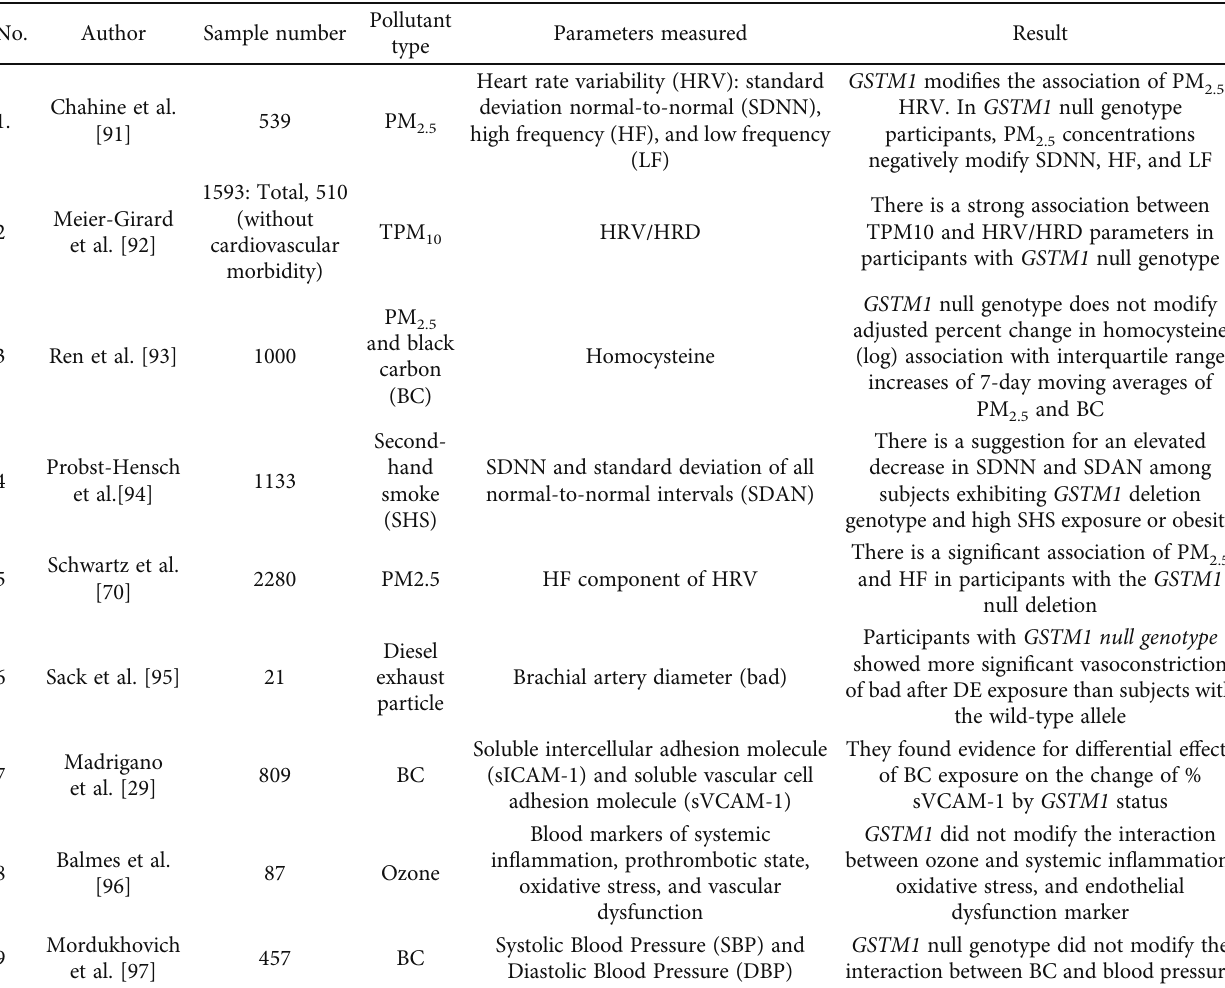
Table 3: Studies about GSTM1 null genotype e ff ect on air pollutant-induced cardiovascular